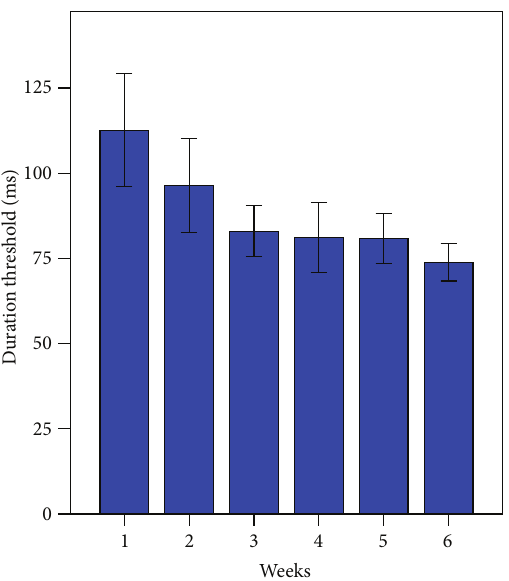
Figure 4: Week-to-week duration threshold scores for the Melodic Contour Training Program (Duration group). Error bars indicate 1 standard error. Figure 5: Baseline and posttraining SRTs for AuSTIN. Error bars indicate 1 standard error.